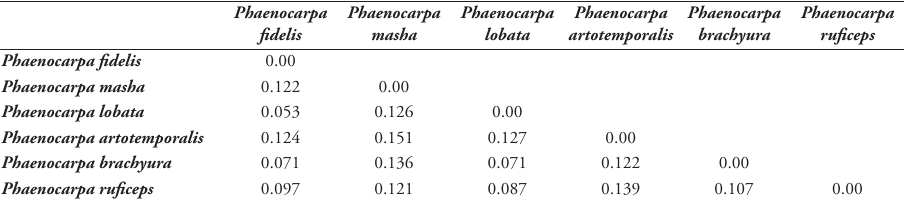
Table 1. COI pairwise genetic distances between the Phaenocarpa species known from South